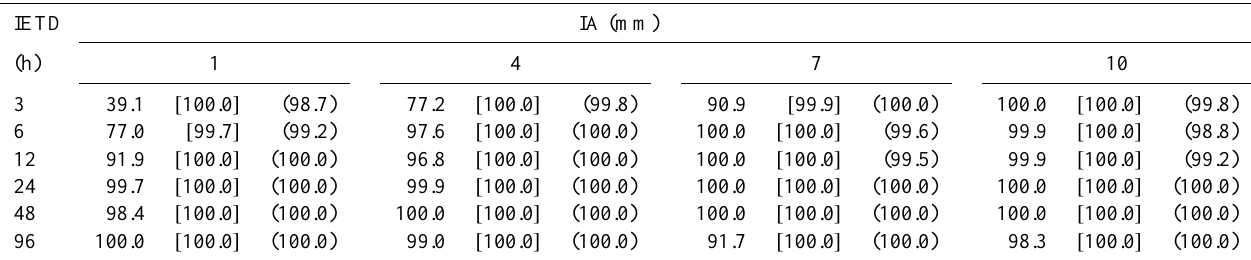
Table 6. p -values (%) obtained when testing the goodness-of-fit of the Gumbel-Hougaard model to the event volume and the wet weather duration pair for the rainfall series of Brescia, Parma [.], and Naples (.). IETD IA